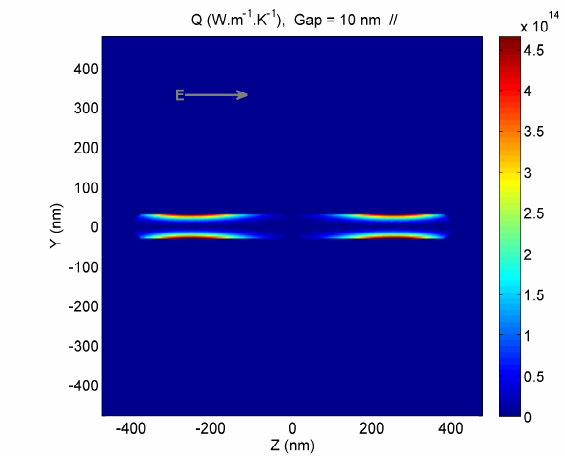
Figure 1: Intensity | E | 2 showing the high confinement of light in the gap between the gold dimer, L = 400 nm, R 1 = 30 nm and a 10 nm gap.